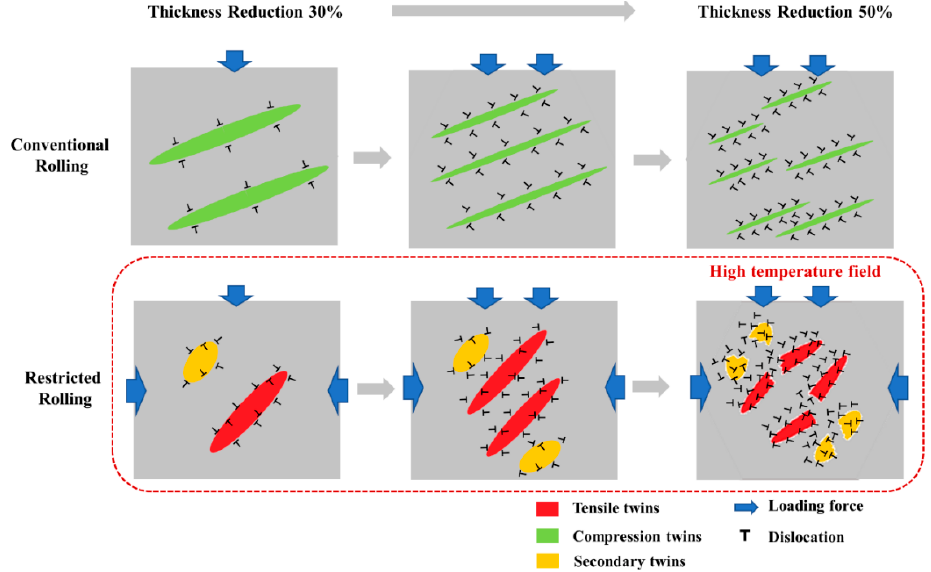
Figure 15. The coordination of twins and dislocations.